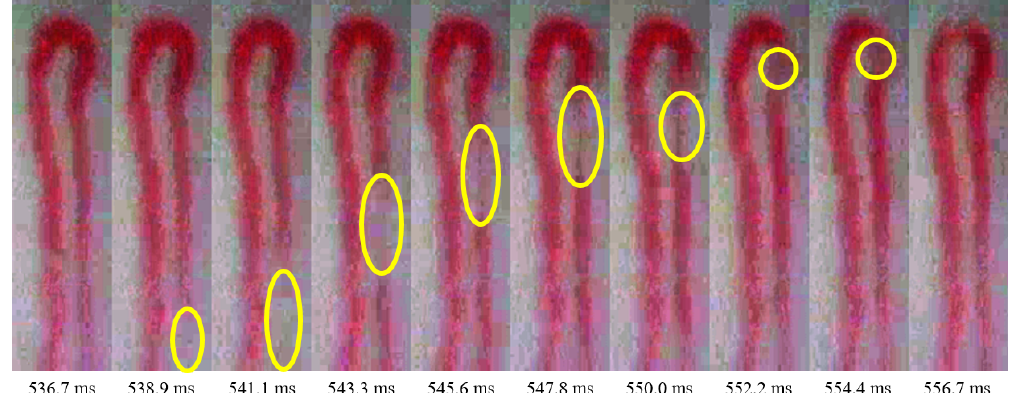
Figure 1. Example of a WBC event (black ellipse) over a sequence of nailfold capillary